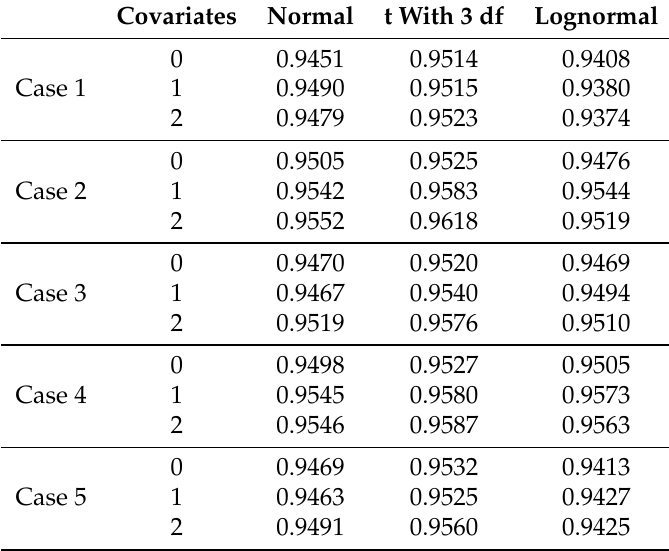
Table 7. Estimated empirical coverage of nominal 95% confidence intervals for ANCOVA with robust standard